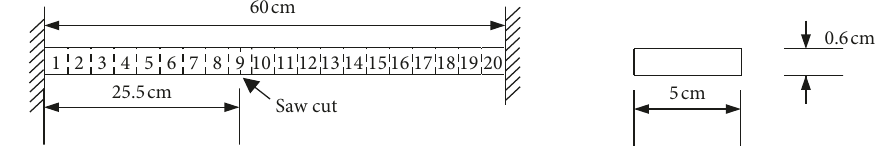
Figure 16: The structure for the experimental study.